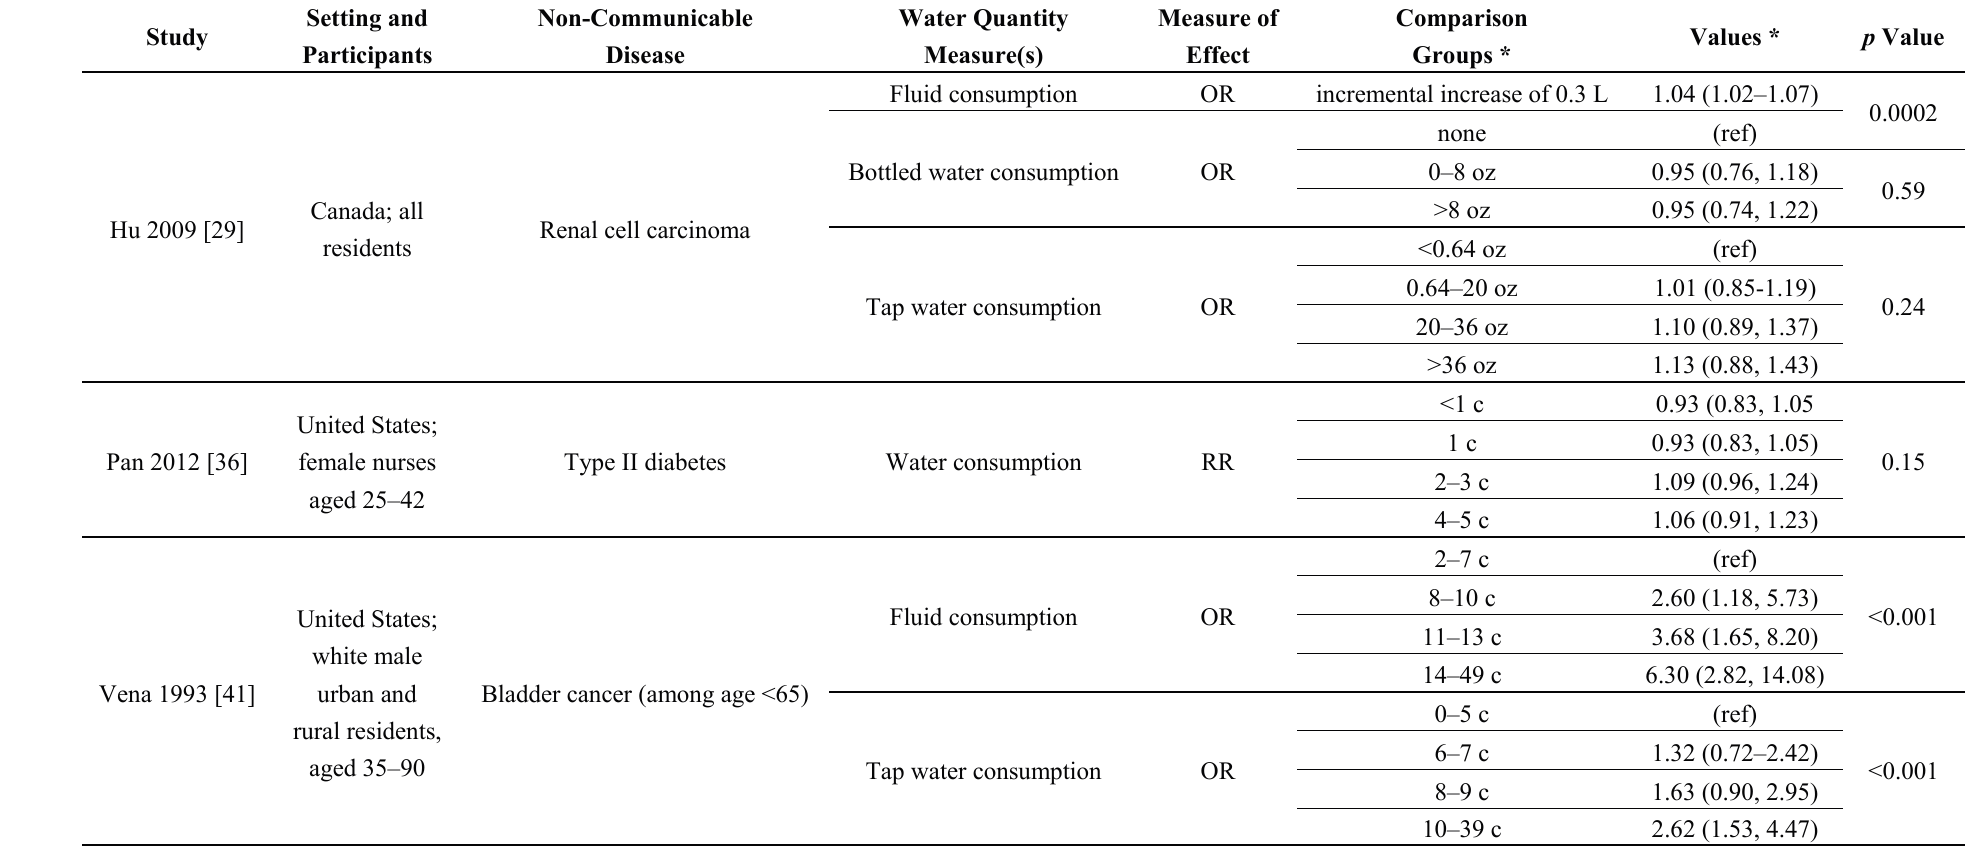
Table 5. Effects of Water Quantity on Non-Communicable Disease (NCD)